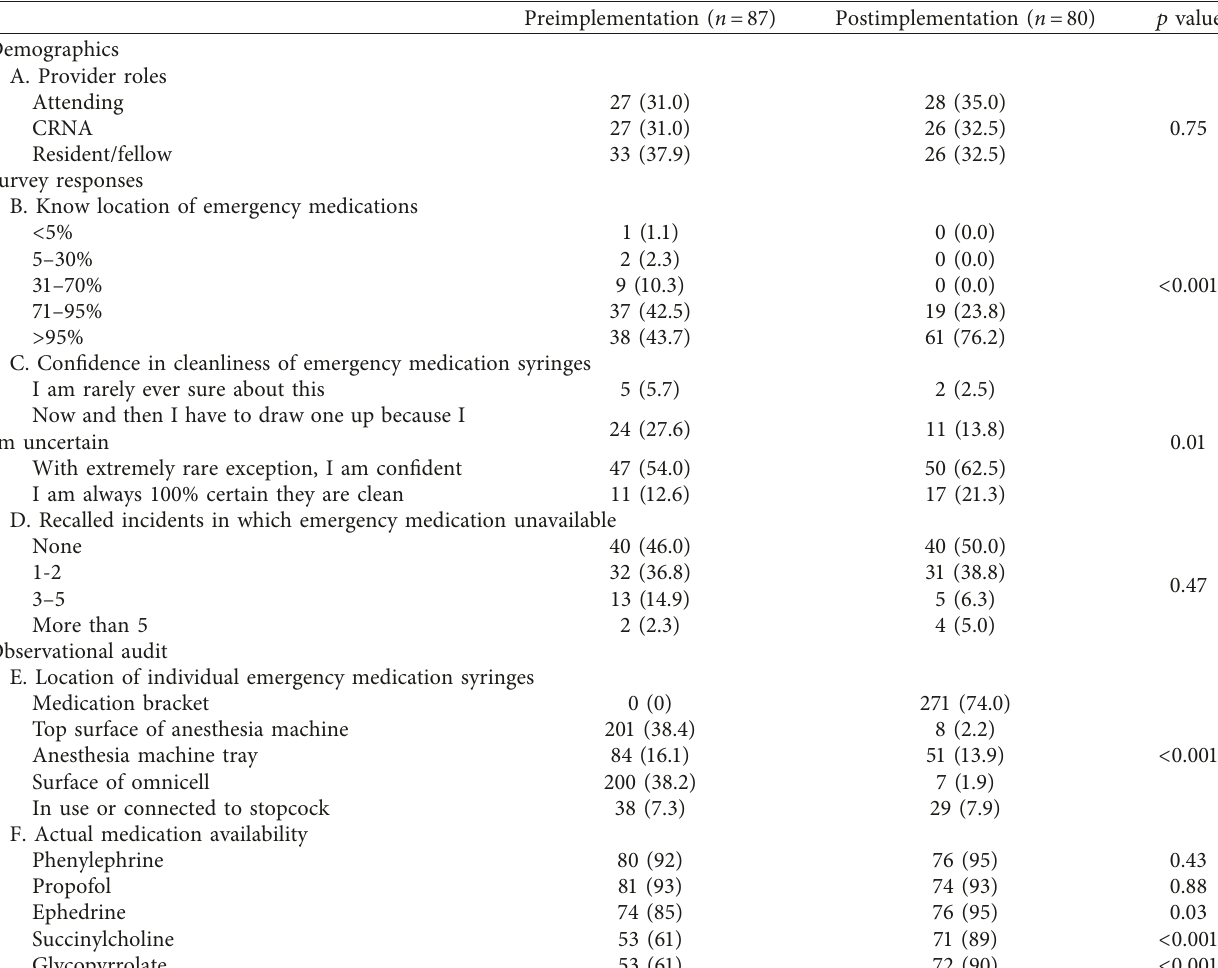
Table 1: Comparison of participant composition by clinical role, self-reported survey responses, and results of simultaneous observational audit, before and after implementation of system-wide implementation of emergency medication syringe brackets. Values reported as count